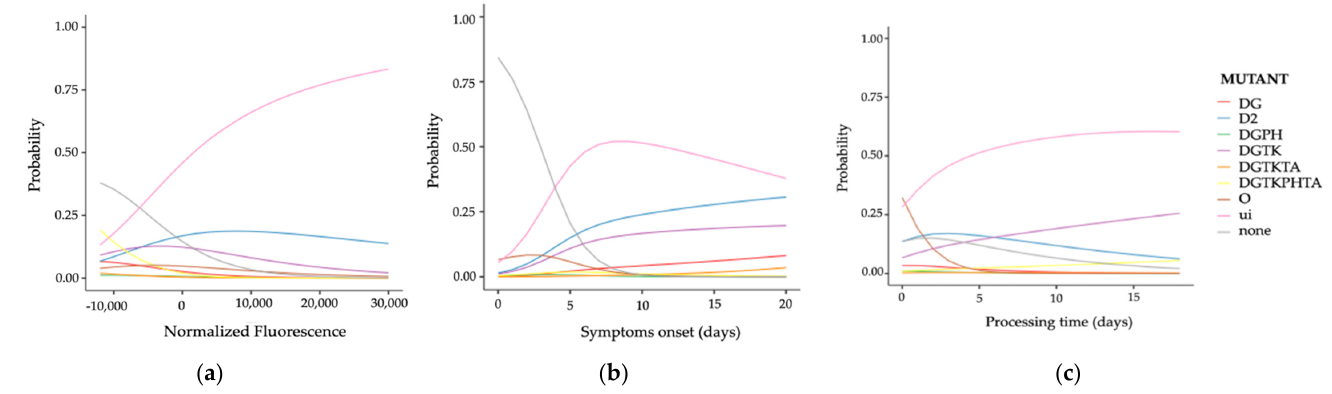
Figure 10. Estimated marginal means plots for ( a ) normalized fluorescence; ( b ) time for Symptoms onset and ( c ) time for sample processing.